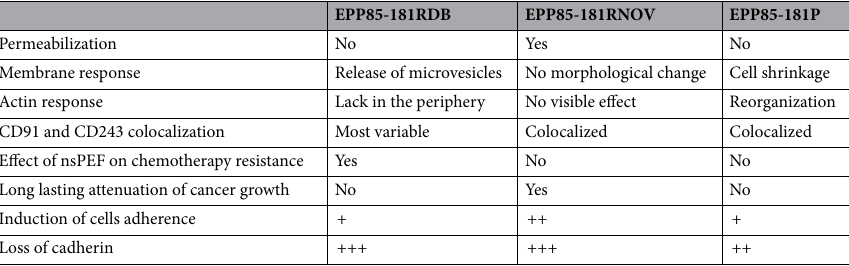
Table 2. Summary of the molecular effects of nsPEF on pancreatic cancer cells (+ slight effect, ++ moderate effect, +++ high effect).